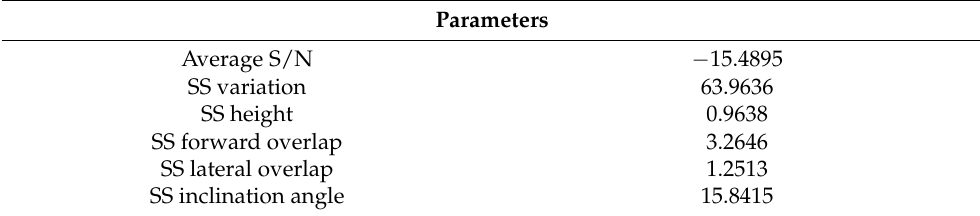
Table 9. Statistical values associated to each parameters.